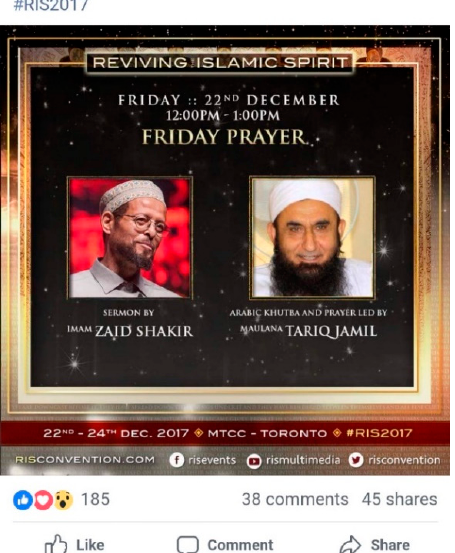
Figure 6. A Facebook poster advertising Maulana Tariq Jamil co-delivering the Friday prayer